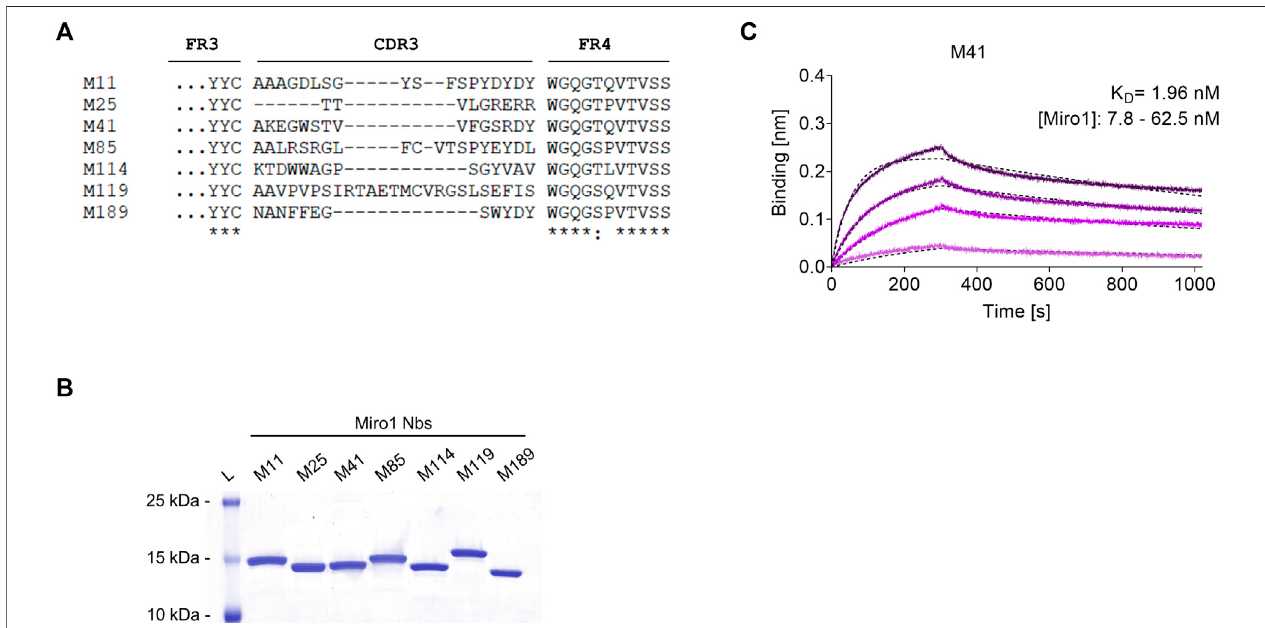
FIGURE 1 | Biochemical characterization of Miro1 speci fi c Nbs. (A) Amino acid sequence alignment of the complementary determining region (CDR) 3 of seven unique Miro1-Nbs positively identi fi ed by phage ELISA (complete amino acid sequences of all Miro1-Nbs are shown in Supplementary Table S2 ). (B) Recombinant expression and puri fi cation of Nbs using immobilized metal af fi nity chromatography (IMAC) and size exclusion chromatography (SEC). (C) For biolayer interferometry based af fi nity measurements, Miro1-Nbs were biotinylated and immobilized on streptavidin sensors. Kinetic measurements were performed by using four concentrations of puri fi ed Miro1 As an example, the sensogram of Miro1 at concentrations 7.8, 15.6, 31.2, and 62.5 nM on immobilized M41-Nb (illustrated with increasingly darker shades from low to high concentration) is shown and global 1:1 fi ts are illustrated as dashed line (upper panel).